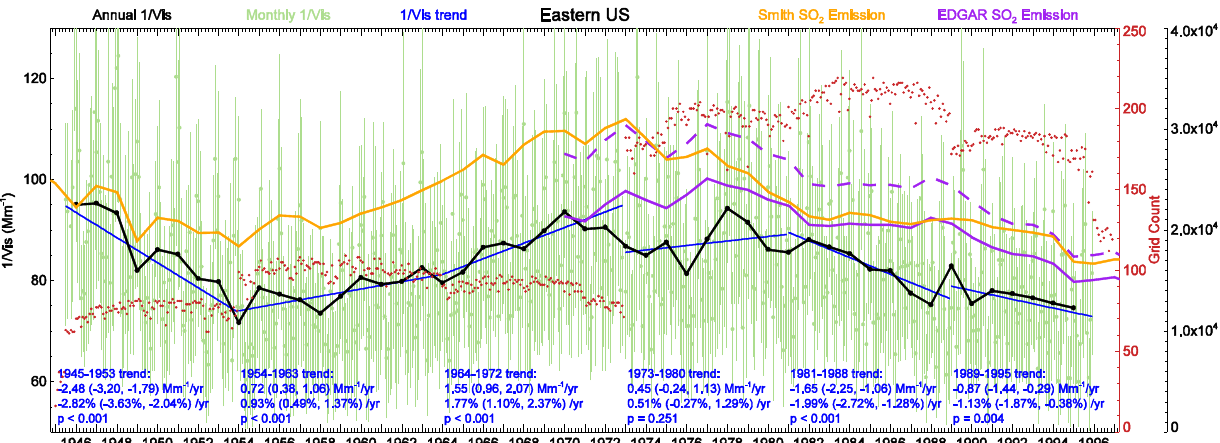
Figure 8. Composite time series of 1/Vis and SO 2 emission over the eastern US region. The long ticks on the horizontal axis indicate January of the year, where all annual values are plotted. Light green dots represent the average monthly 1/Vis of all qualified stations (error bars showing the 25th and 75th percentile) in the defined region. Red dots show the number of grid cells for averaging, and data gaps indicate months with less than 75% of the total grids for each period. Blue lines and text represent the 1/Vis trends calculated using the monthly anomalies for each period. Trends in parentheses are the 95% confidence intervals. Black lines are the annual 1/Vis averaged from at least 8 monthly values. SO 2 emissions for the entire US from S. J. Smith et al. (2011a) are in orange. Purple indicates EDGAR SO 2 emissions for the entire US (dashed) and for the defined region (solid) in Fig.